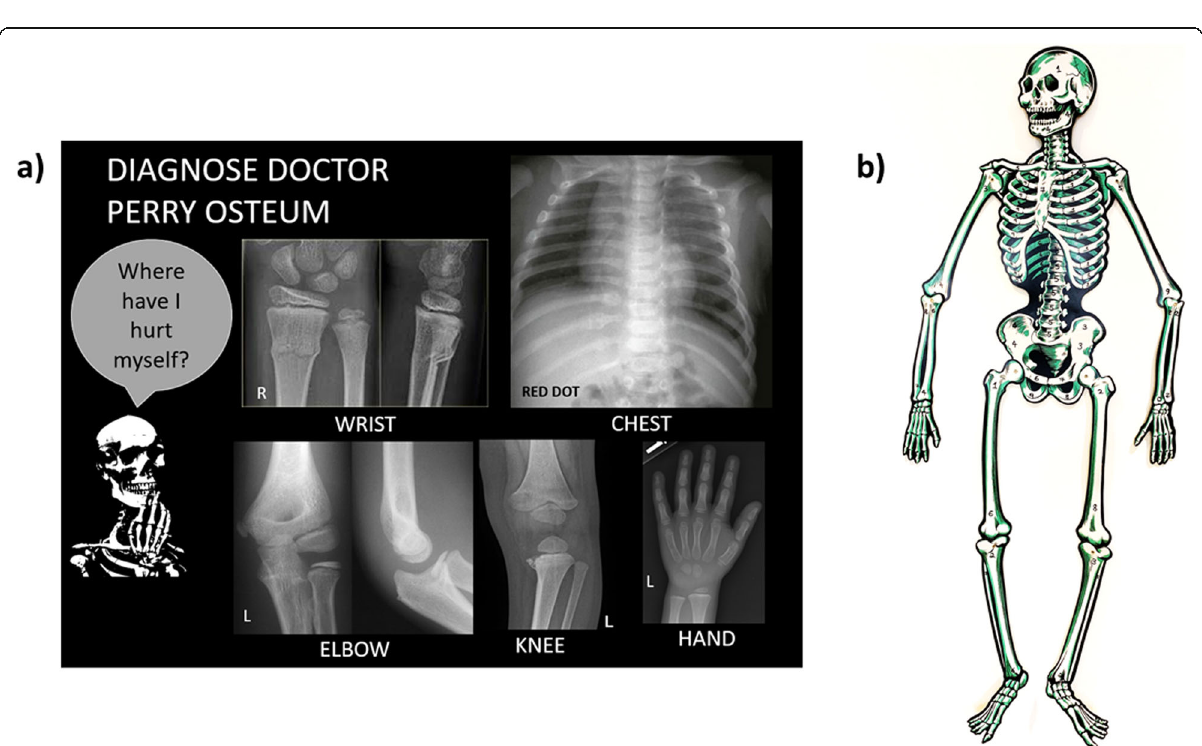
Fig. 3 ‘ Diagnose Doctor Perry Osteum ’ : another example of a puzzle in the escape room. a A poster of various body parts some with and some without fractures are shown. The participants need to identify which bones have an abnormality and match it to the ( b ) large paper skeleton in the other corner of the room. This skeleton has numbers written on every bone, and only by correlating the correct bone and laterality can the students resolve the three-number combination. In this example, the bones to be interrogated on the skeleton would be the distal right radius, posterior right ribs and proximal left